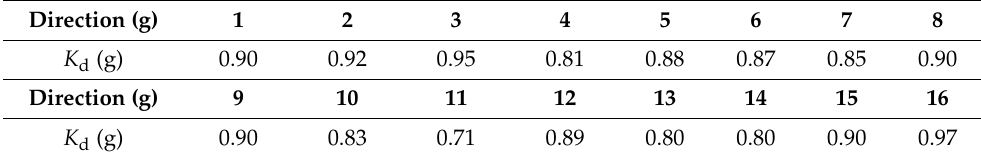
Table 4. Directionality factors K d (g) of typical taps (Tap.96) in unknown building orientations. Direction